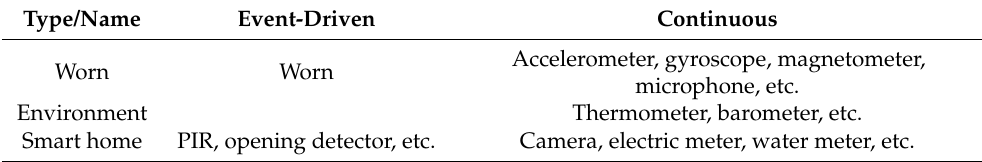
Table 1. Classification of